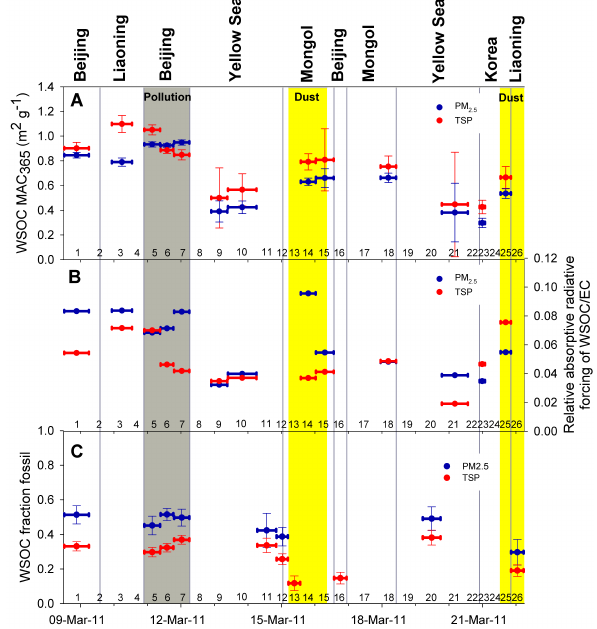
Fig. 3. Mass absorption cross section of water-soluble brown car- bon (WSOC) at 365nm (MAC 365 ) (A) ; relative absorptive radiative forcing of WSOC compared to that of elemental carbon (EC) (B) ; radiocarbon-based source-apportionment measurements of fraction fossil in PM 2 . 5 and TSP aerosols at KCOG station during the GoPoEx campaign (C)